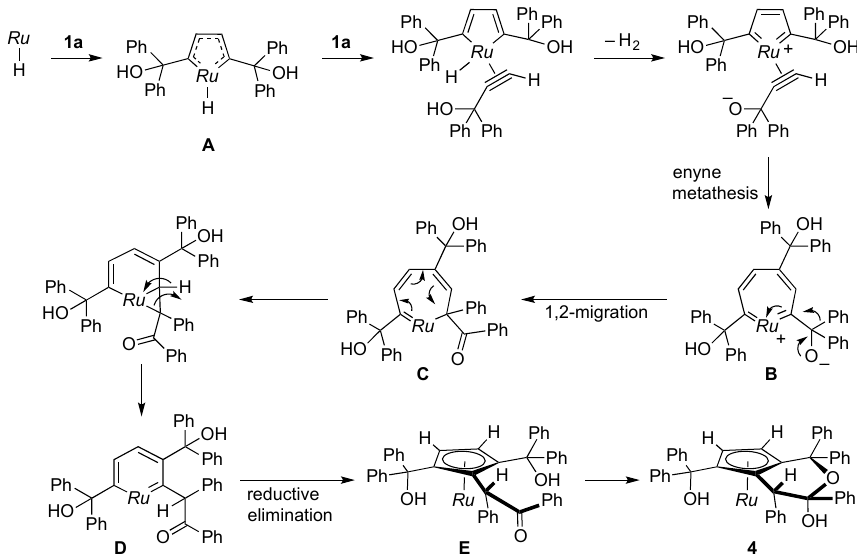
Scheme 6. Proposed mechanism for formation of 4 . Ru =